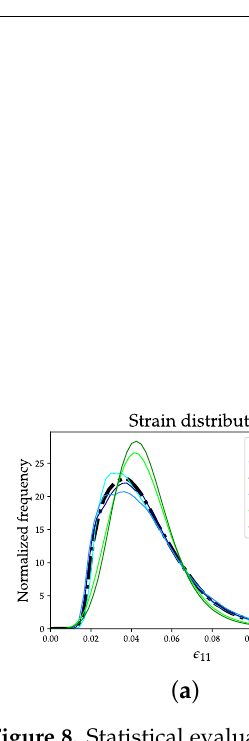
Figure 8. Statistical evaluation: ( a ) Strain and ( b ) stress distributions. ( c ) Number of points with values above a certain threshold. The threshold values are selected to obtain around 1% frequency for the data of the experimental